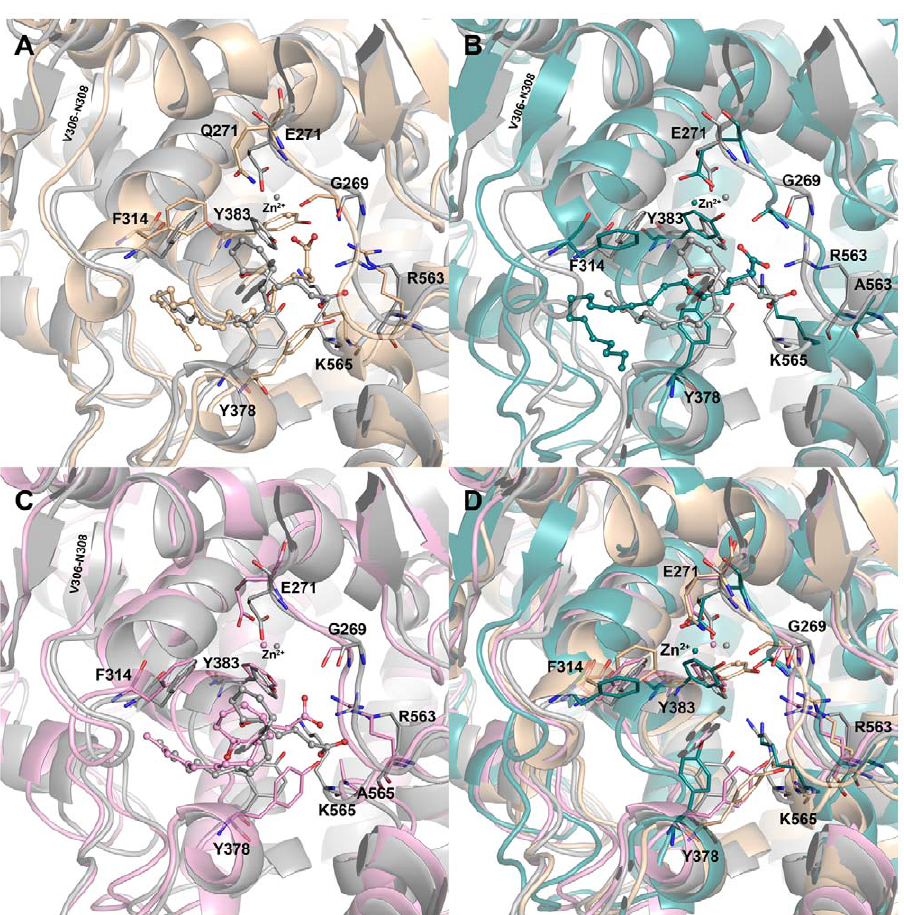
Figure 9. Overlay of WT and mutant systems of L-LTA4 complexes to observe the structural changes. (A) WT and E271Q systems, (B) WT and R563A systems, (C) WT and K565A systems, and (D) all L-LTA4 systems. The WT, E21Q, R563A, and K565A systems are shown in grey, wheat, deep teal, and pink colors, respectively. The amino acid residues and LTA4 are shown in think stick and ball-stick forms, respectively. The metal ion (zinc) present at the active site is shown in sphere form.